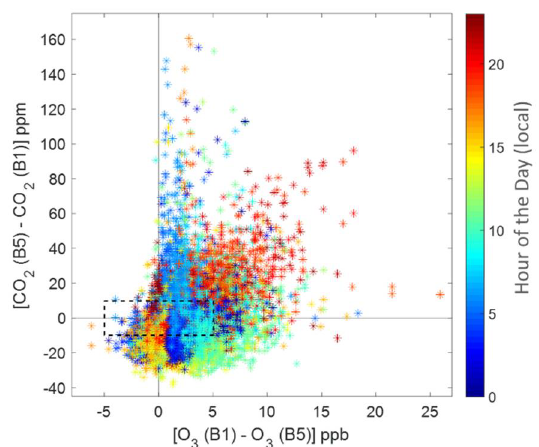
Figure A6. Scatter plot of differences between B1 and B5 (on the x-axis, for O 3 , B1–B5; and on the y-axis, for CO 2 , B5–B1), colored by the hour of the day. The dotted lines around the center axes indicate the respective RMSEs for CO 2 and O 3 .